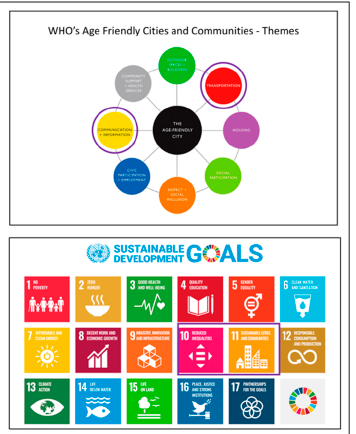
Figure 1. The two key themes of the WHO’s Age-Friendly Cities and Communities and of the UN’s Sustainable Development Goals(highlighted in purple) most relevant to this paper. Author’sillustration, based on illustrations by [72] and by